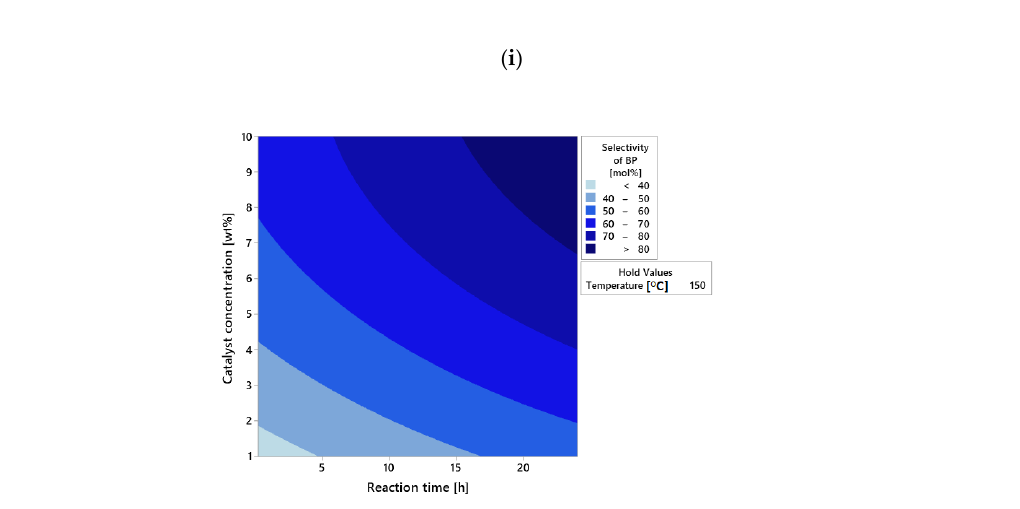
Figure 11. The in fl uence of transformation process parameters on β -pinene selectivity.